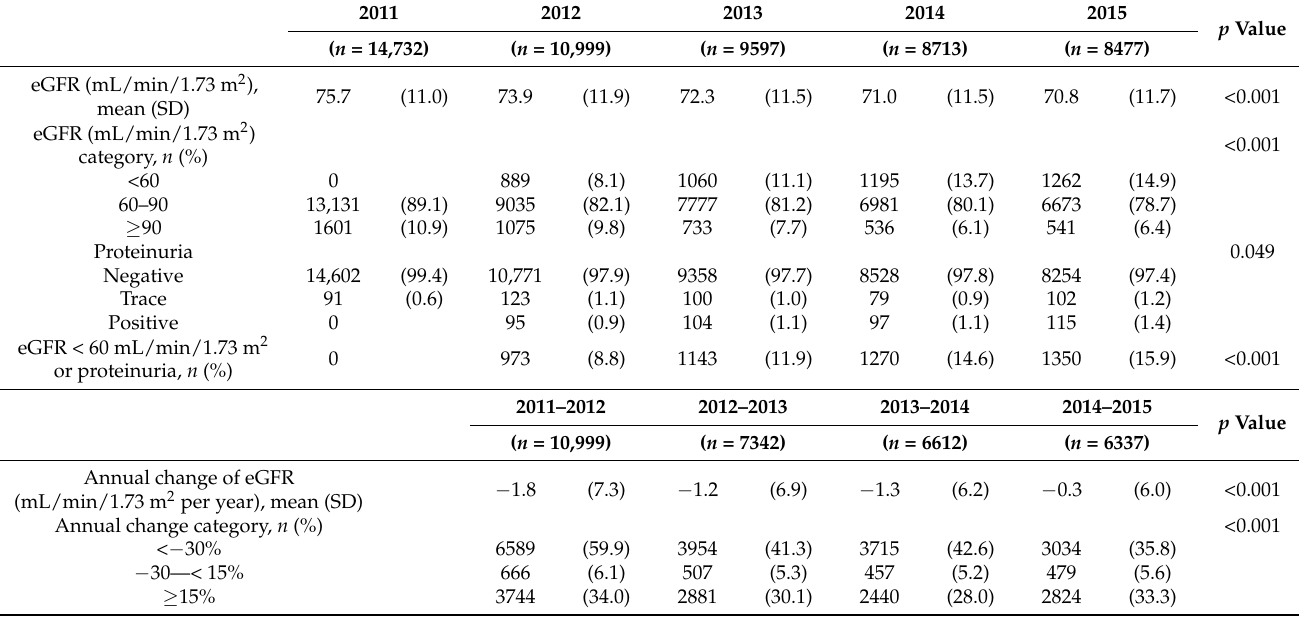
Table 3. Kidney function in participants at follow-up years, 2012–2015,